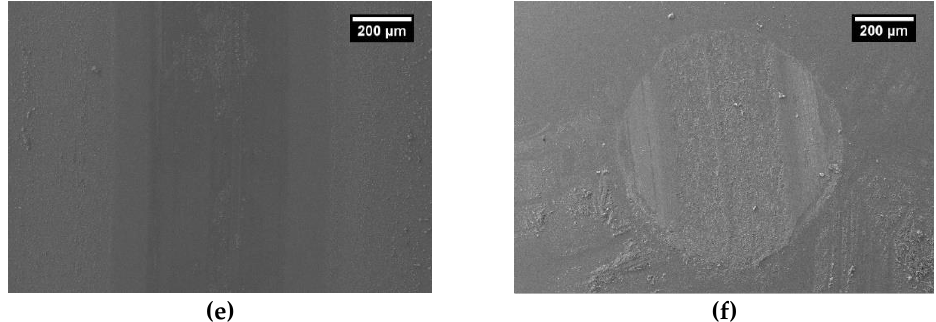
Figure 8. SEM images of pin-on-disk at high temperature (150 °C) of the coating wear track ( a ) DCMS, ( c ) HIPIMS, ( e ) HIPIMS CH4 and steel ball wear scar, ( b ) DCMS, ( d ) HIPIMS and ( f ) HIPIMS CH4.